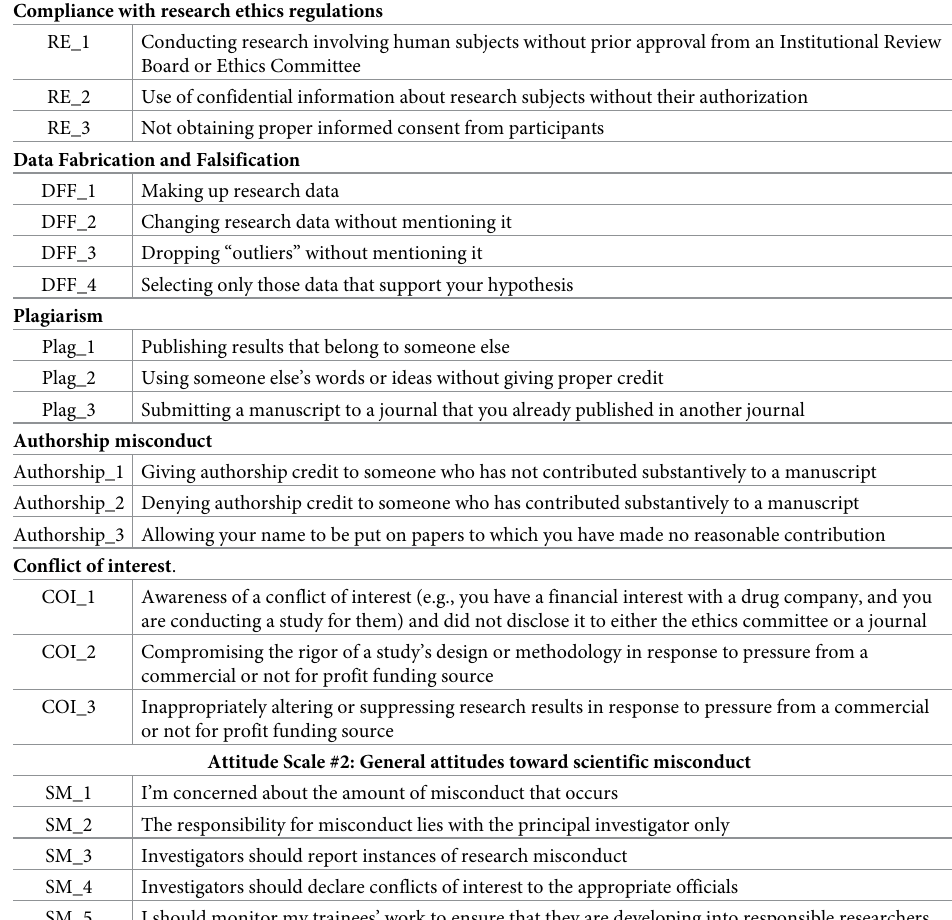
Table 1. Items in the attitude scales. Attitude Scale #1: Attitudes toward the acceptability of RCR practices Compliance with research ethics